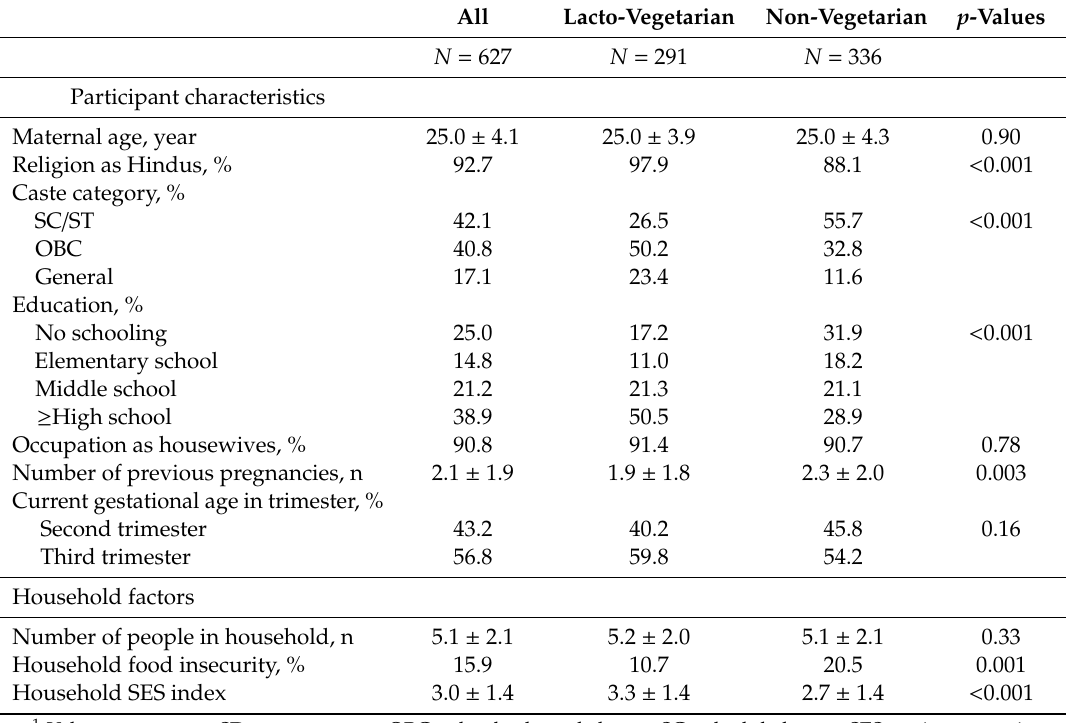
Table 1. Descriptive statistics of the study participants 1 .